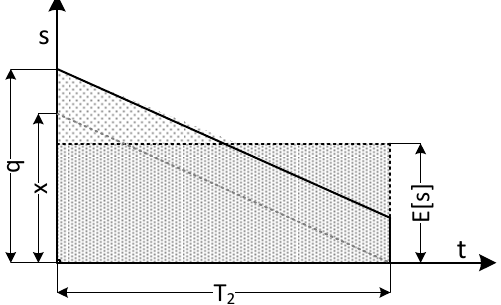
Fig. 1. Average stock when the purchased quantity exceeds demand in T